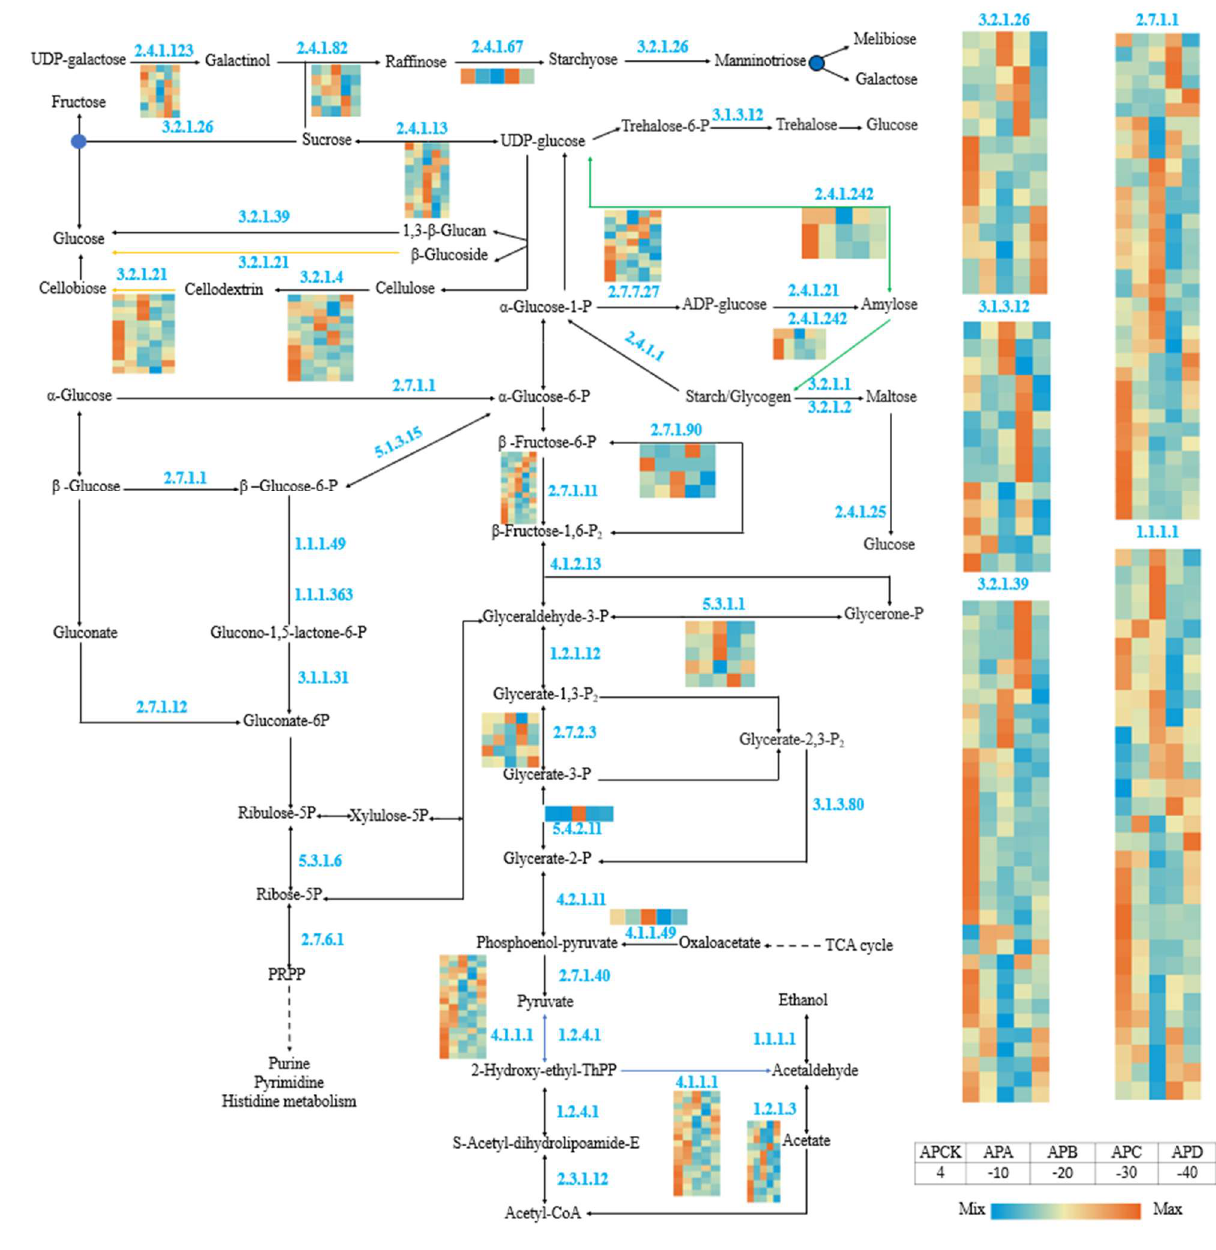
Figure 7. Expression of DEGs in the gluconeogenic pathway of A. pseudosieboldianum under freezing stress at different temperatures. The heat map shows the differential gene expression of A. pseudosieboldianum under freezing stress at different temperatures compared to CK (4 °C).